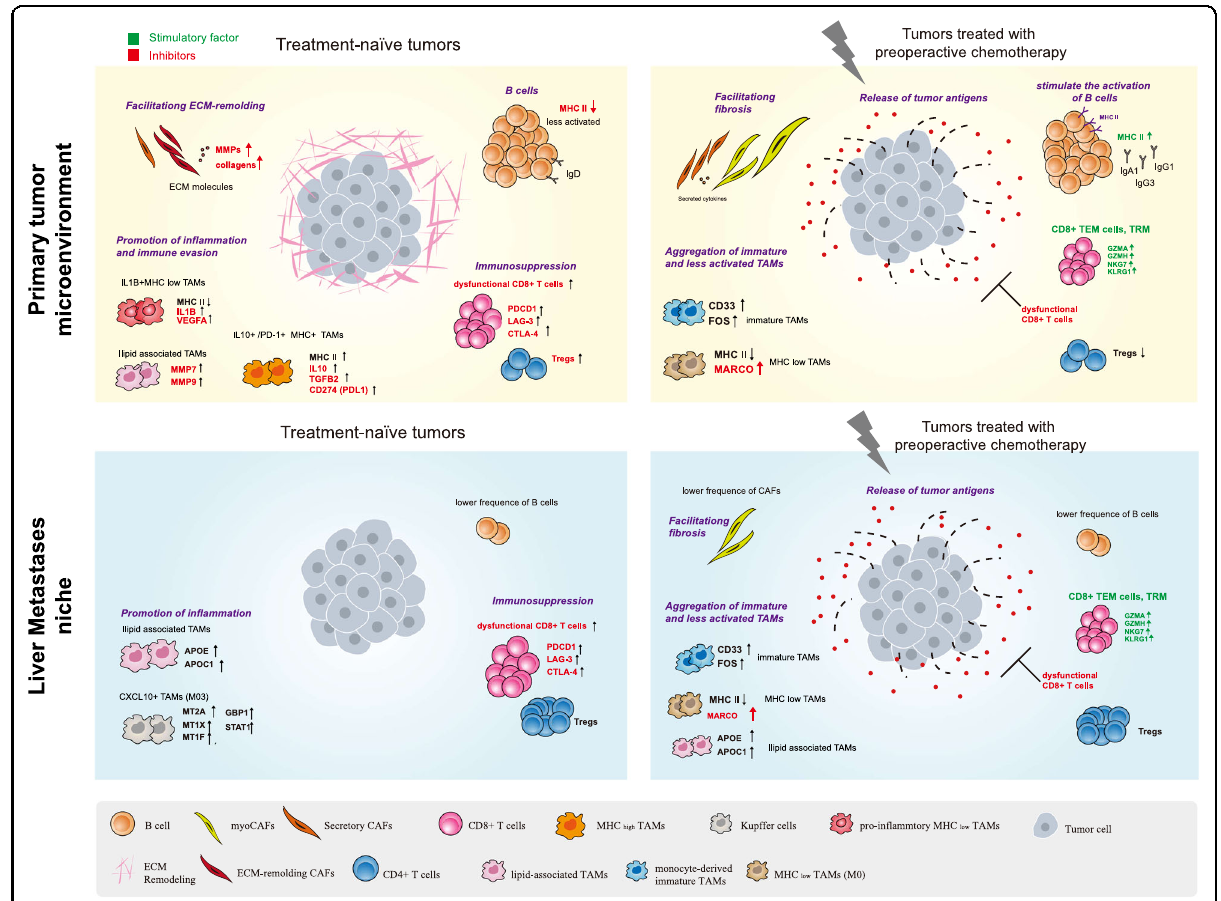
Fig. 7 Diagram illustrating the reprogramming of TME in response to PC. The reprogramming of TME in response to PC. Top, schematic diagram of the reprogramming of TME in treatment-naïve (left) and treated (right) tumor in the primary CRC. Bottom, schematic diagram of the reprogramming of TME in treatment-naïve (left) and treated (right) tumor in liver